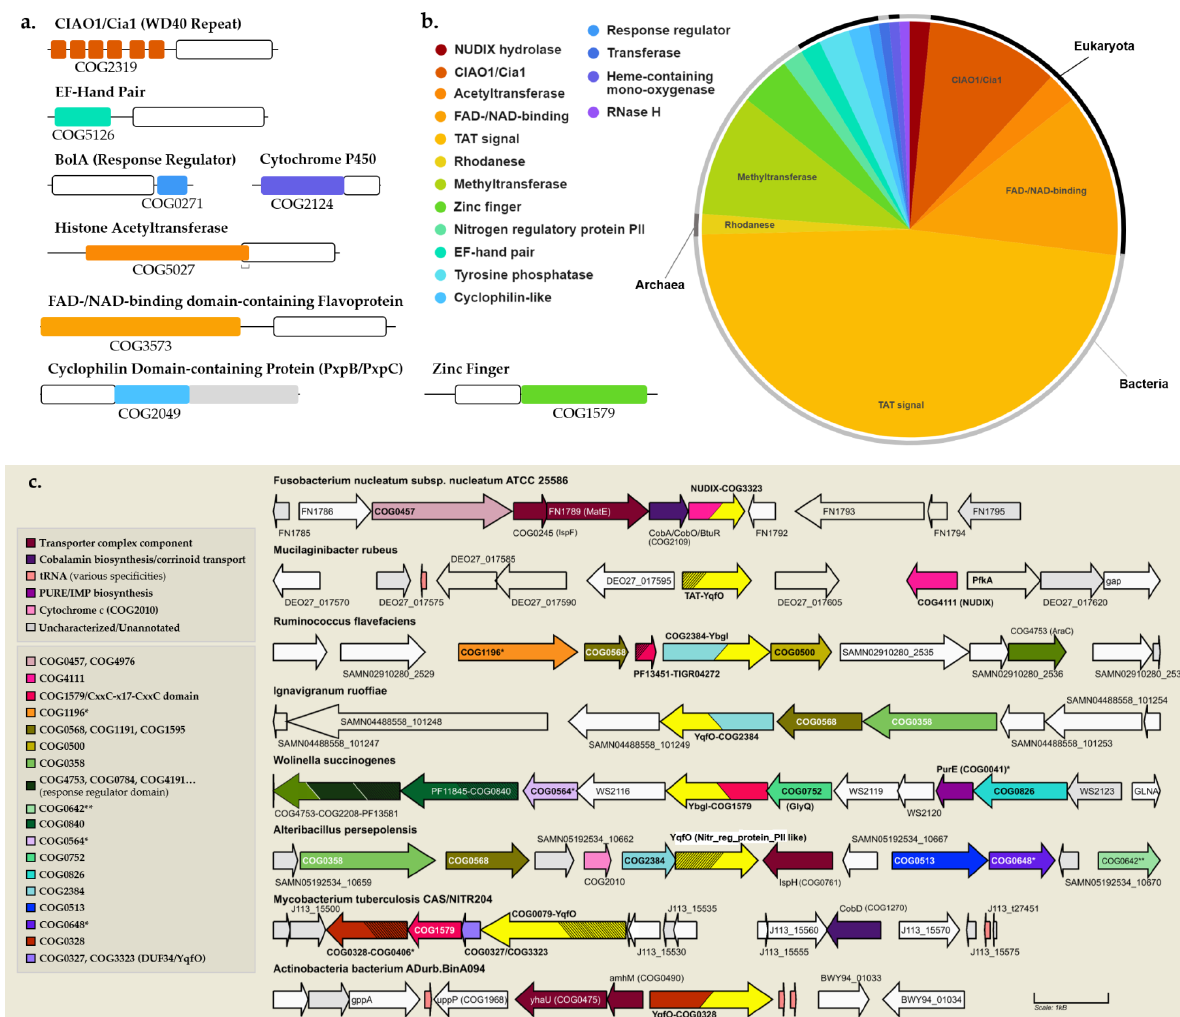
Figure 7. DUF34 fusions and select gene neighborhoods. ( a ) Domain architectures of DUF34 fusions. The domain rendering dimensions and positions are approximate. DUF34 domains are rendered in white with black outlines. Domain colors correspond to the key shown in panel b. COGs of fusion domains are listed below each. Fusions deemed “invalid” or “inconclusive” were excluded for panels a and b. ( b ) Pie chart of DUF34 fusions (126 sequences, total). The outer halo surrounding chart indicates the superkingdoms in which respective fusions were observed (Eukaryota: black; Archaea: dark gray; Bacteria: light gray). ( c ) Neighborhoods of select bacterial and archaeal fusions are shown (12 kb, each), all of at least “conditional” validation confidence (Data Table S11). DUF34 is depicted in bright yellow and fusion domains are indicated by hashing or alternative coloring. For DUF34 sequence labels, “YqfO” denotes a sequence also containing inserted domain, COG3323, while “YbgI” denotes a sequence without the inserted COG3323 domain. Rendered fusion domains do not reflect exact sizes or locations. The color key is divided into two sets of identities (gray boxes): (top) general metabolic theme or specific annotation with bioinformatic precedent; and (bottom) COGs observed in physical clustering analysis (PCA). COGs also observed in PCA (Table 3) are shown in bold. Six minor exceptions to the top-20 rank cut-off are shown in bold with an asterisk (*): COG1196 (top 31st); COG0564 (top 23rd); COG0648 (top 25th); COG0406 (top 48th) in a fusion with COG0328; and COG0041 (top 36th). Others observed in rep. operons but were ranked beyond the “minor exception” threshold (exceeded top-50) in PCA are shown without additional symbols, not bolded: COG0245 (116th) and COG0761 (61st). Finally, one was not observed in PCA (not bolded) but was in at least one rep. operon (double asterisk, **): COG0642 (SAMN05192534_10671 of A. persepolensis ; rep. operon, Desulfurispirillum indicum S5 ) (Data Table S7). Note: COG4111 (NUDIX hydrolase), present in panel c (neighborhood of M. rubeus ), was absent from PCA (any rank) and rep. operons, despite the fusion with COG3323 in F. nucleatum having been resolved in preceding homolog capture and literature review.